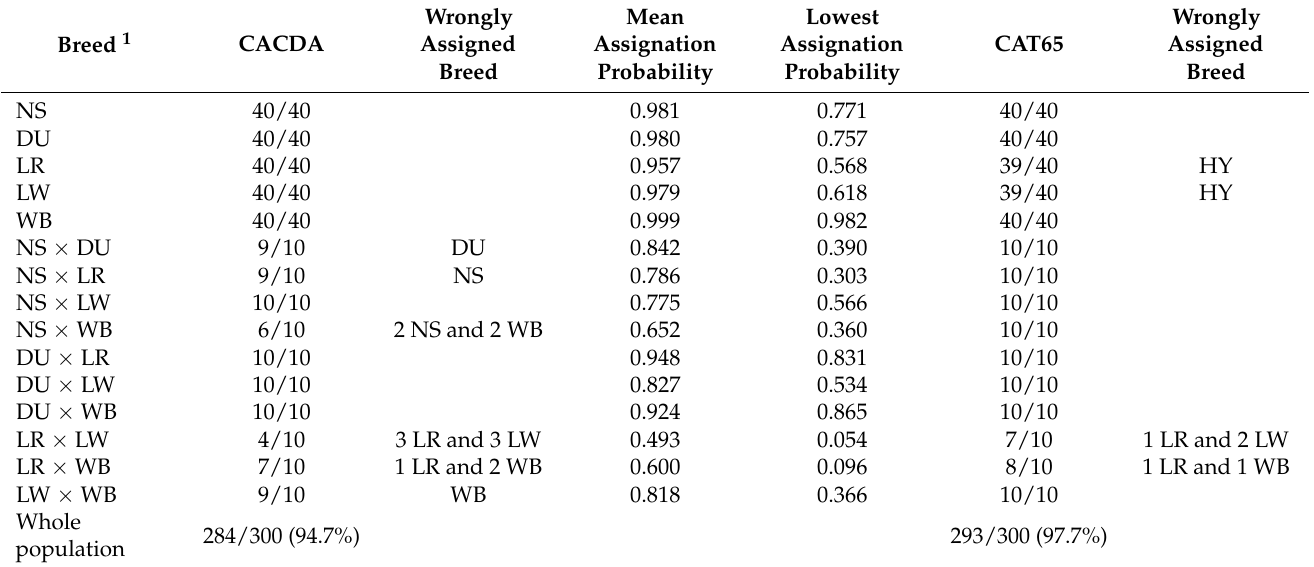
Table 3. Assignation statistics. The number of individuals correctly assigned by the canonical discriminant analysis (CACDA) and with the addition of the threshold at 65% (CAT65); the wrongly assigned breeds are reported together with the mean and the lowest assignation probability to the right